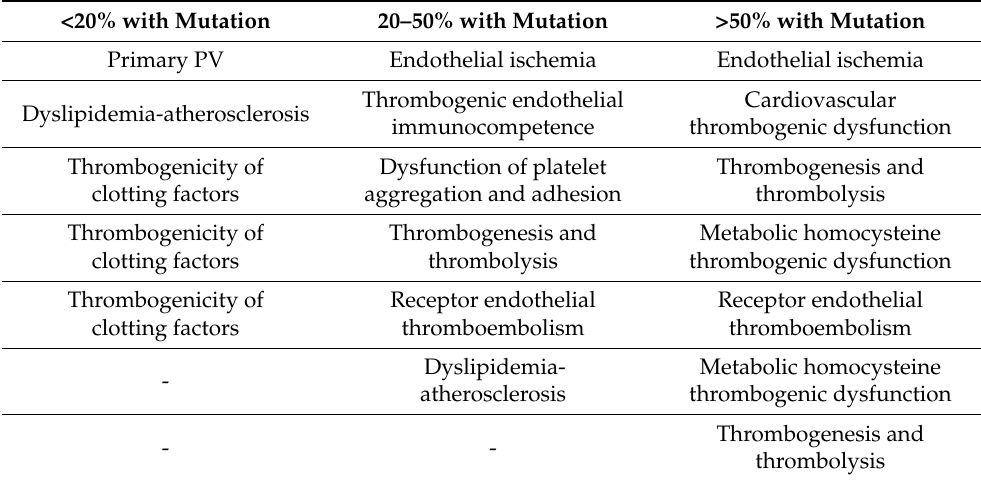
Table 2. Percentage evaluation of results in table after